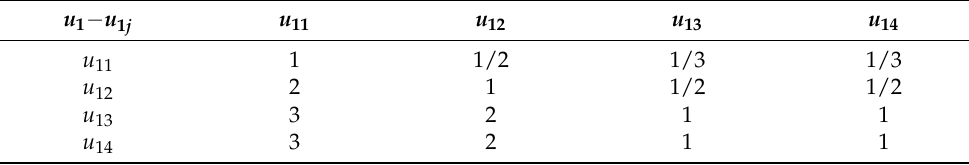
Table 3. Judgment matrix of u 1 − u 1 j .